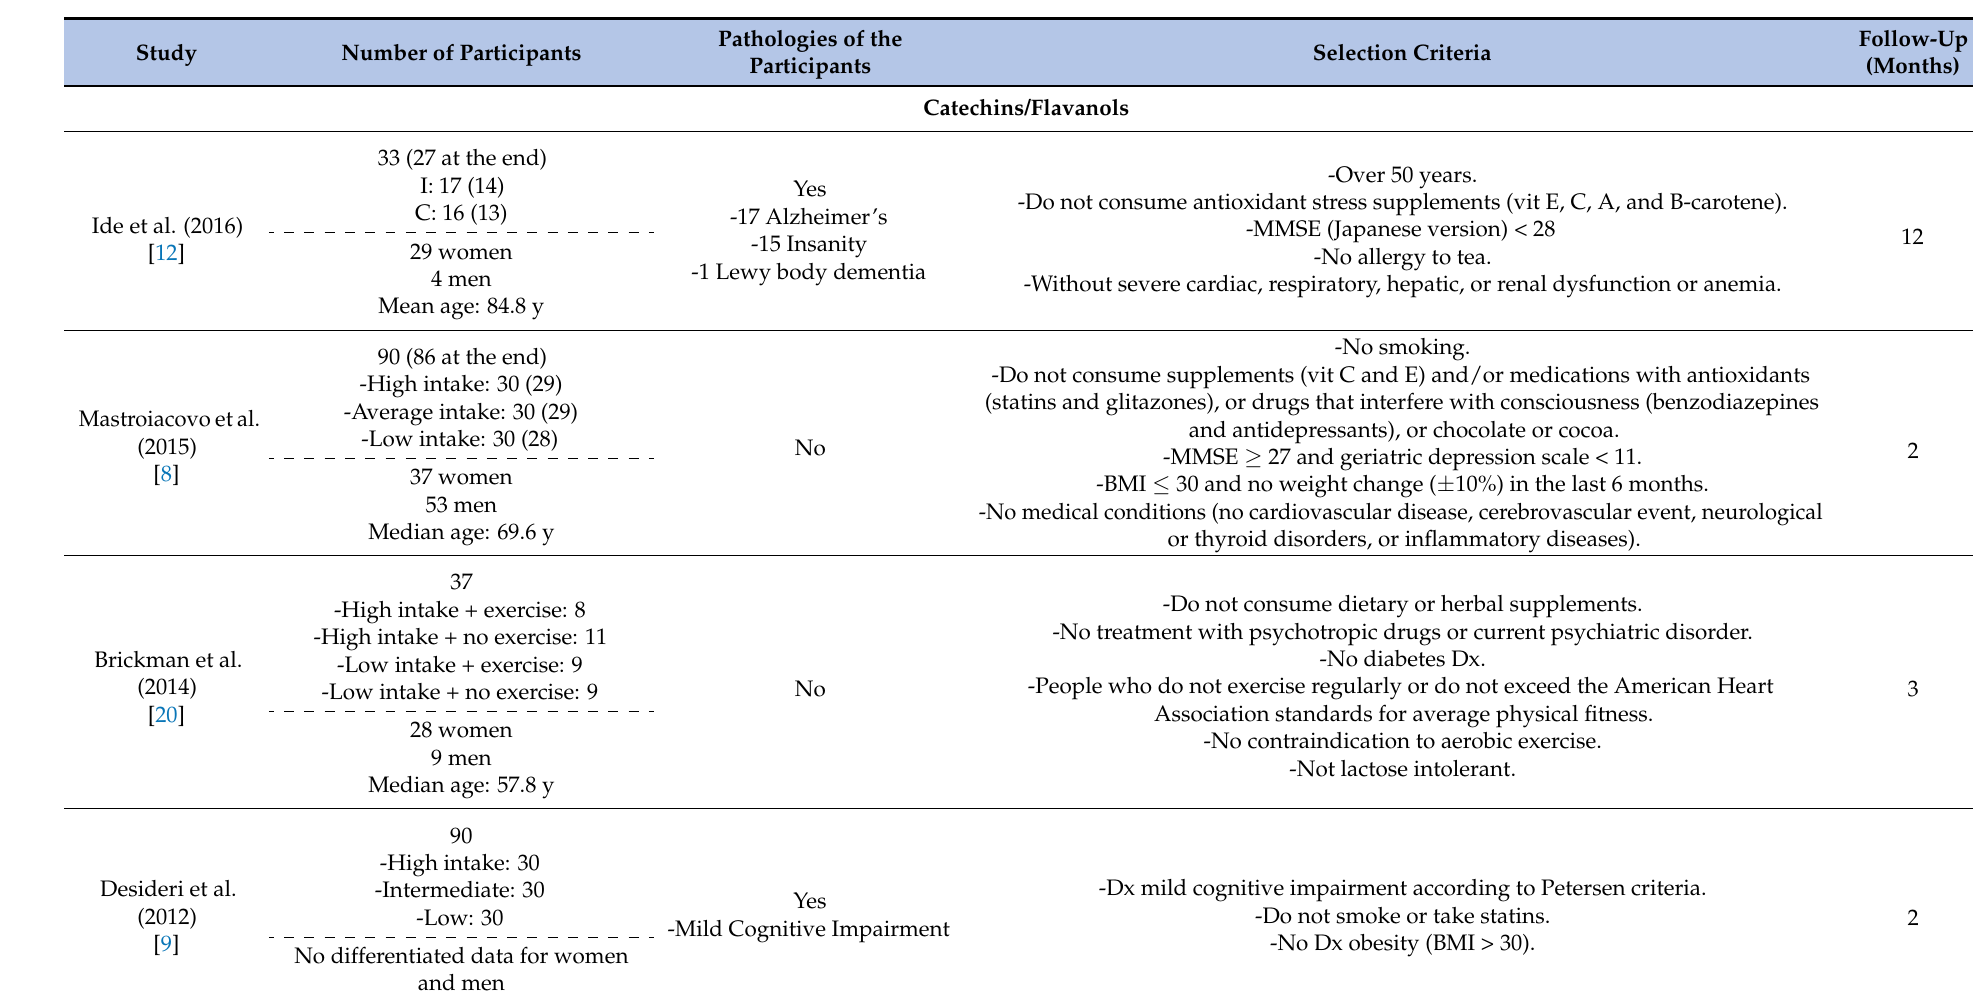
Table 2. Characteristics of included